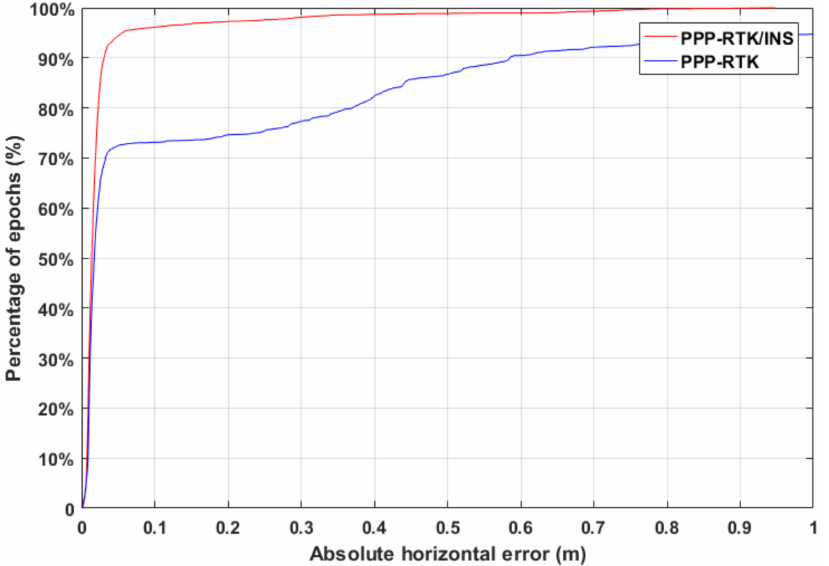
Figure 7. The percentage of horizontal positioning error that does not exceed the specified threshold in experiment